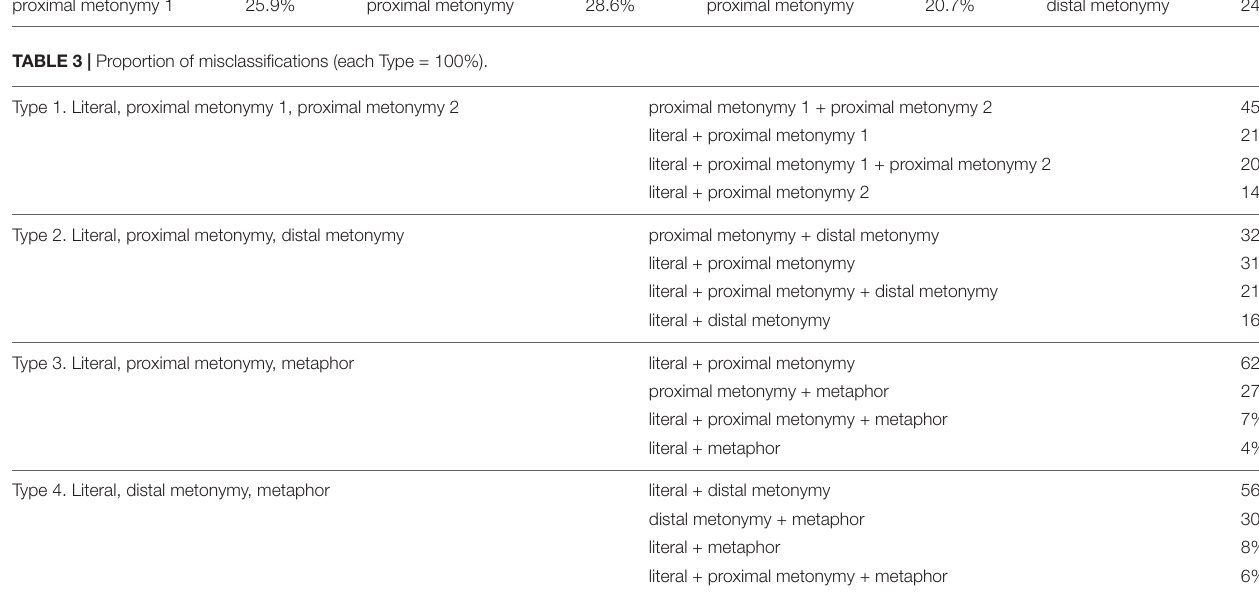
TABLE 3 | Proportion of misclassifications (each Type = 100%).